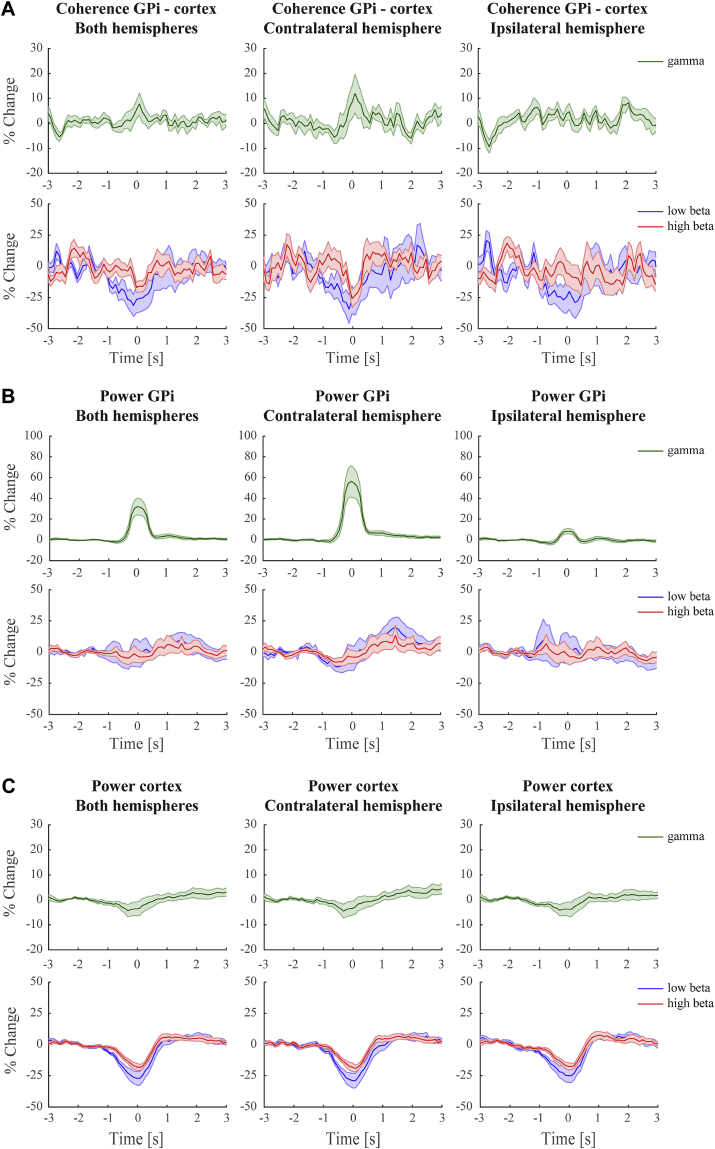
Movement-related coherence and power per frequency (sub)band. This figure shows the time-frequency modulations as presented in Fig. 2 averaged within the gamma (30–90 Hz), low-beta (13–21 Hz), and high-beta (21–30 Hz) range. A) Cortico-pallidal coherence; B) pallidal power; C) cortical power. Shaded bars indicate the standard error of the mean across subjects.